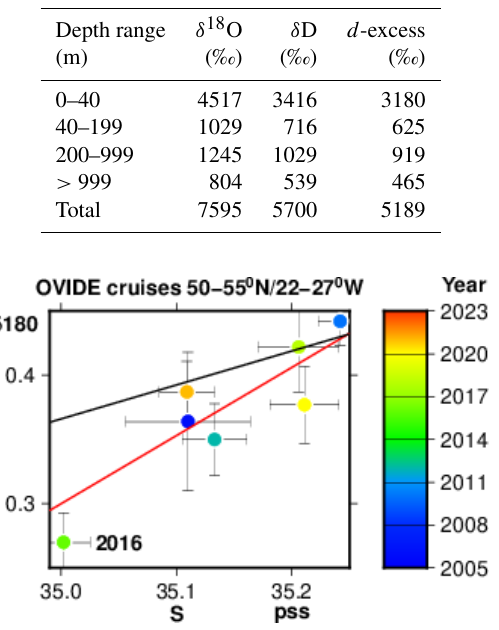
Figure 4. Scatter plot of cruise averages of near-surface (upper 100m) δ 18 O (‰) versus practical salinity in the Iceland Basin, close to the North Atlantic Current fronts. The bars indicate the standard deviation between the individual data that are averaged. Notice the fresher and isotopically lighter data from the BOCATS (OVIDE transect) cruise in 2016. The red line corresponds to the average linear relationship in the southwestern NA SPG (SURAT- LANT dataset within 47–55 ◦ N and 30–49 ◦ W, with practical salin- ity between 33.1 and 35.5), whereas the black line reports the slope expected from mixing with the local rainfall